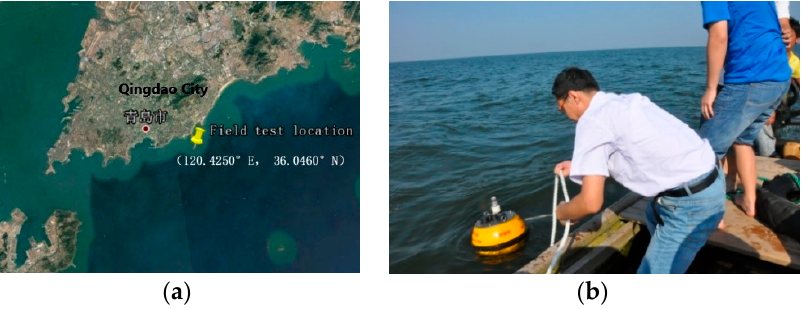
Figure 2. Field test between the SBF7-1A GPS wave buoy and the DWR-MKIII Waverider buoy: ( a ) field test location; ( b ) placing the buoy.